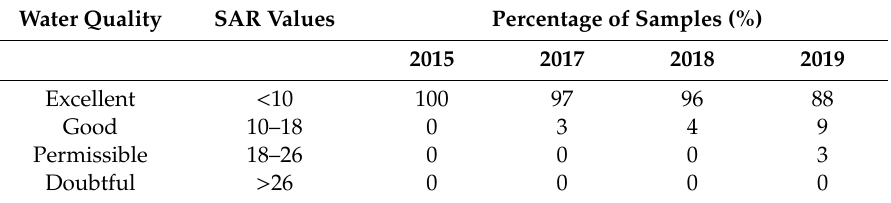
Table 5. Groundwater quality classification based on SAR [47,48]. (SAR = Sodium Adsorption Ratio).